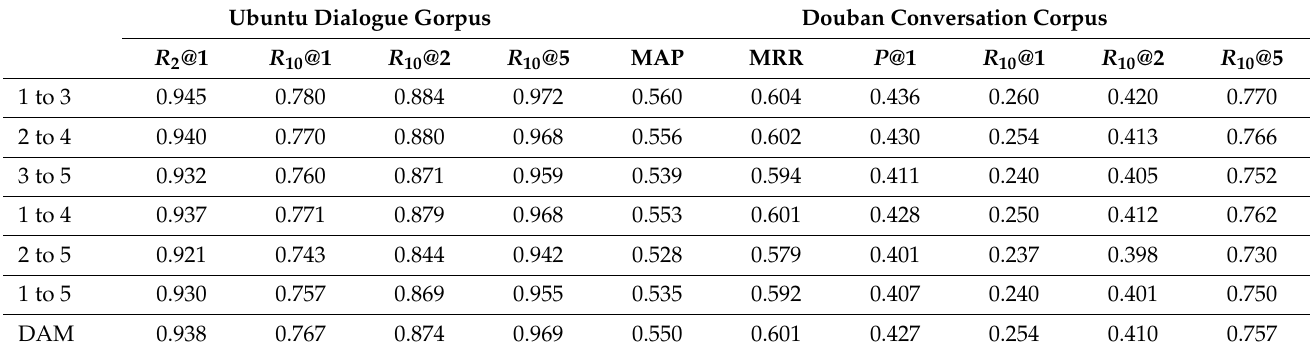
Table 6. Compare the results of the different matching methods under the multi-level shifted cross- attention granularity matching